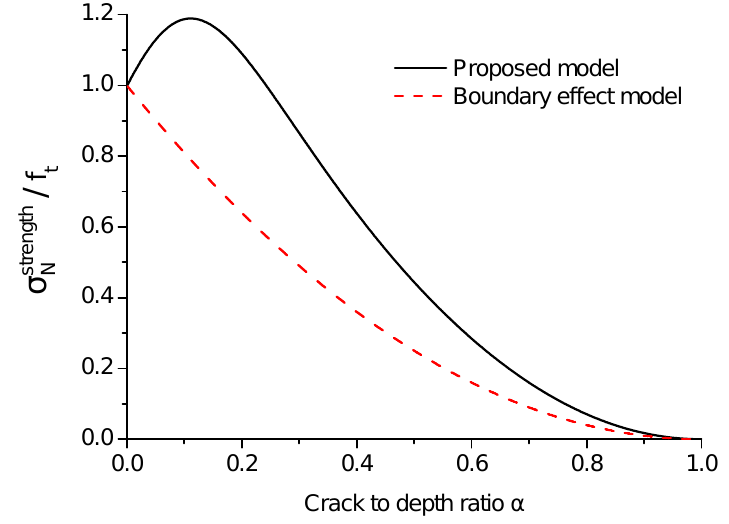
Figure A2. The ratio of the nominal strength predicted by the strength mechanism and tensile strength σ strength / f t for various crack to height N